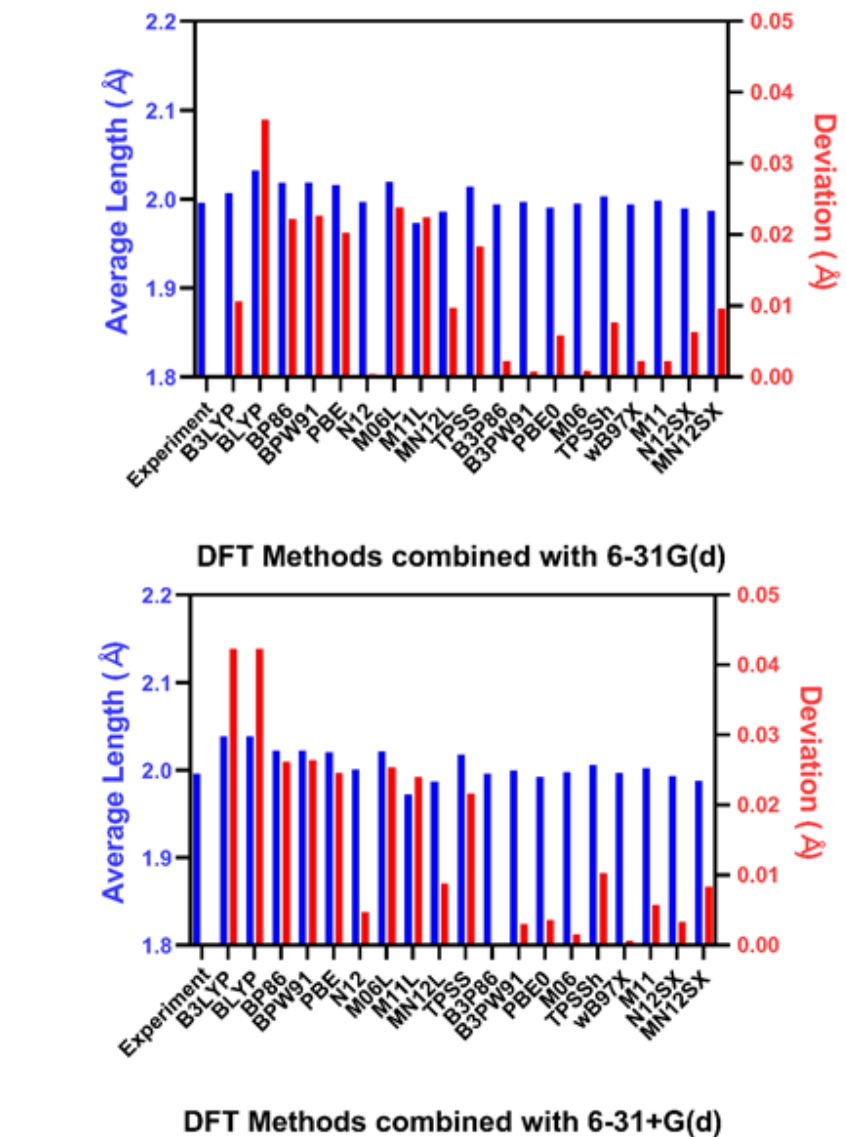
Figure 2. Average length of U-F bonds in the optimized structure with ( a ) 6-31G(d) and ( b ) 6-31+G(d) [23].